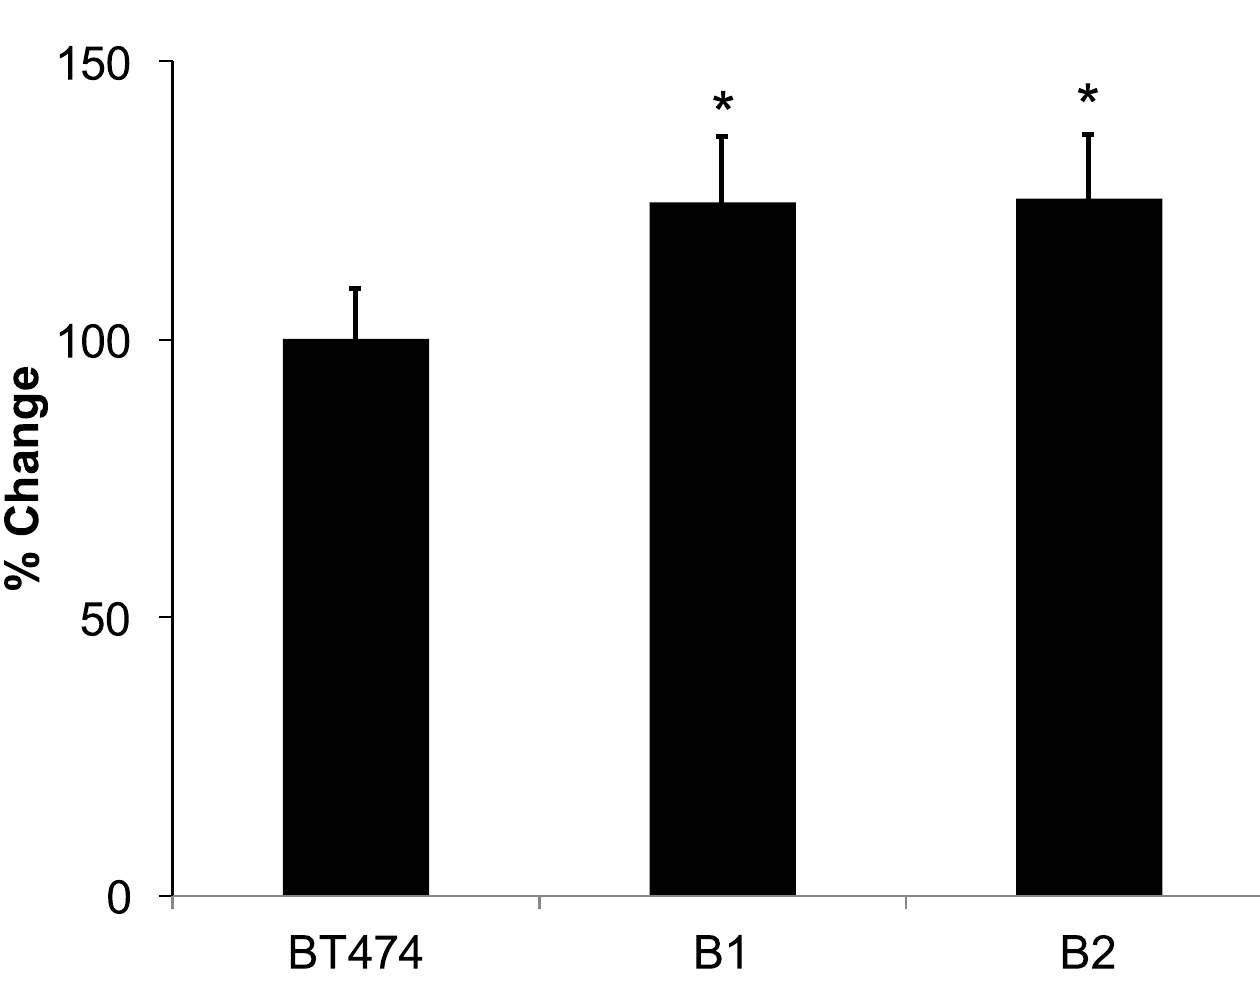
Fig 4. Loss of STAT6 increases growth proliferation rate of clones of BT474 cells. � Indicates statistical significance relative to the respective parental cells. Results are the means ± SEM of three independent experiments (n = 3). % Change refers to the change in proliferation relative to the parental